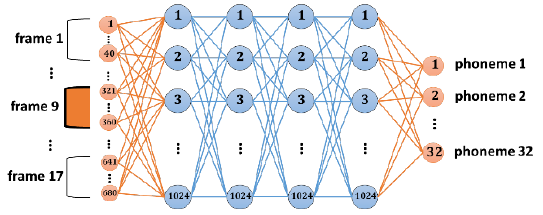
Figure 7. Neural network architecture for phoneme recognition task. The network input comprises a window of 17 consecutive frames including 40 dimensional FBANK features. The output label is the phoneme label of central frame (i.e. 9th frame).